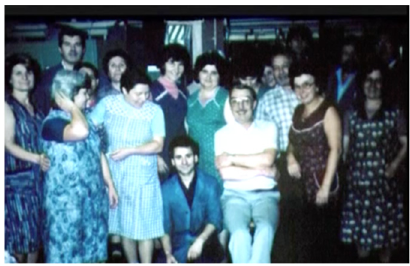
Figure 6. The inner memory María Ruido (2002). Reprinted with permission from María Ruido (2002). Copyright 2002 Copyright Owner’s María Ruido.